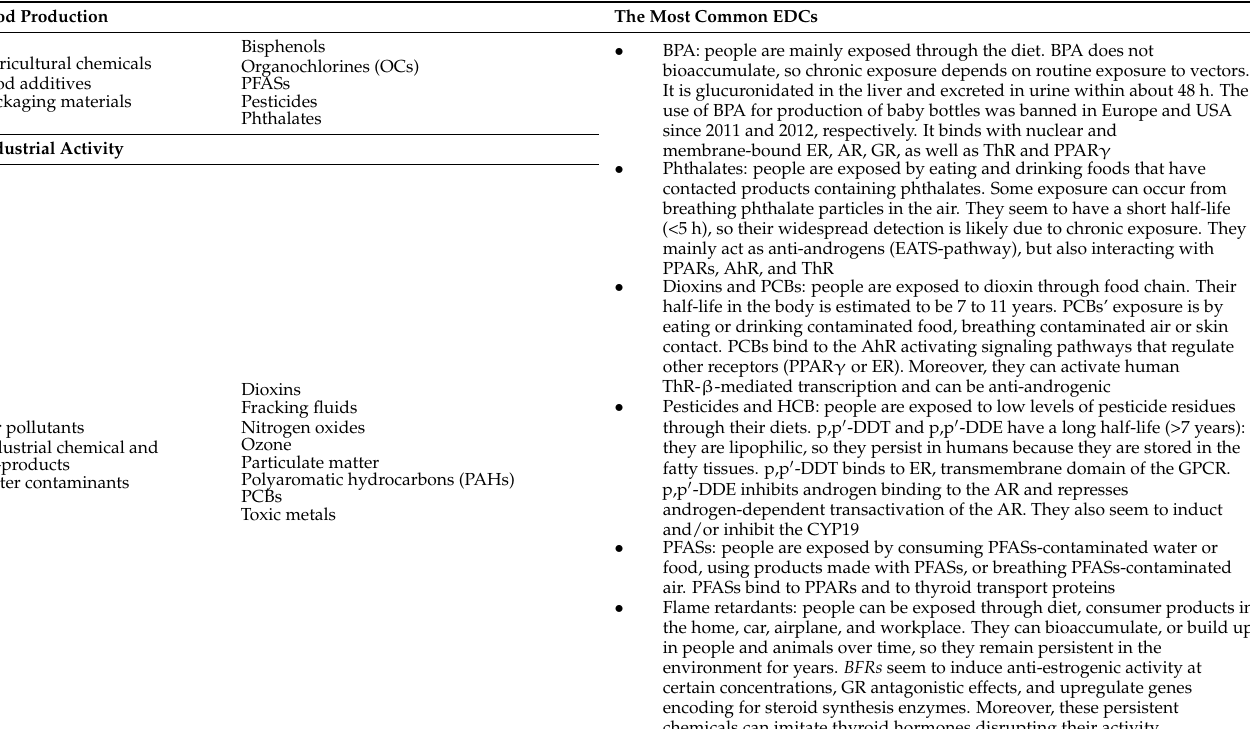
Table 3. Sources and characteristics of the most studied chemicals causing endocrine